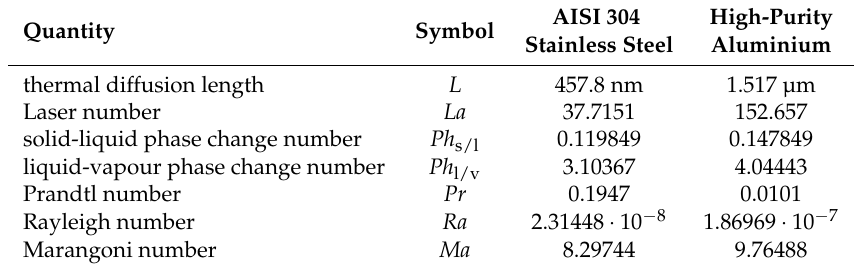
Table 4. Thermal diffusion length and dimensionless quantities of DLIP model for metallic substrates.